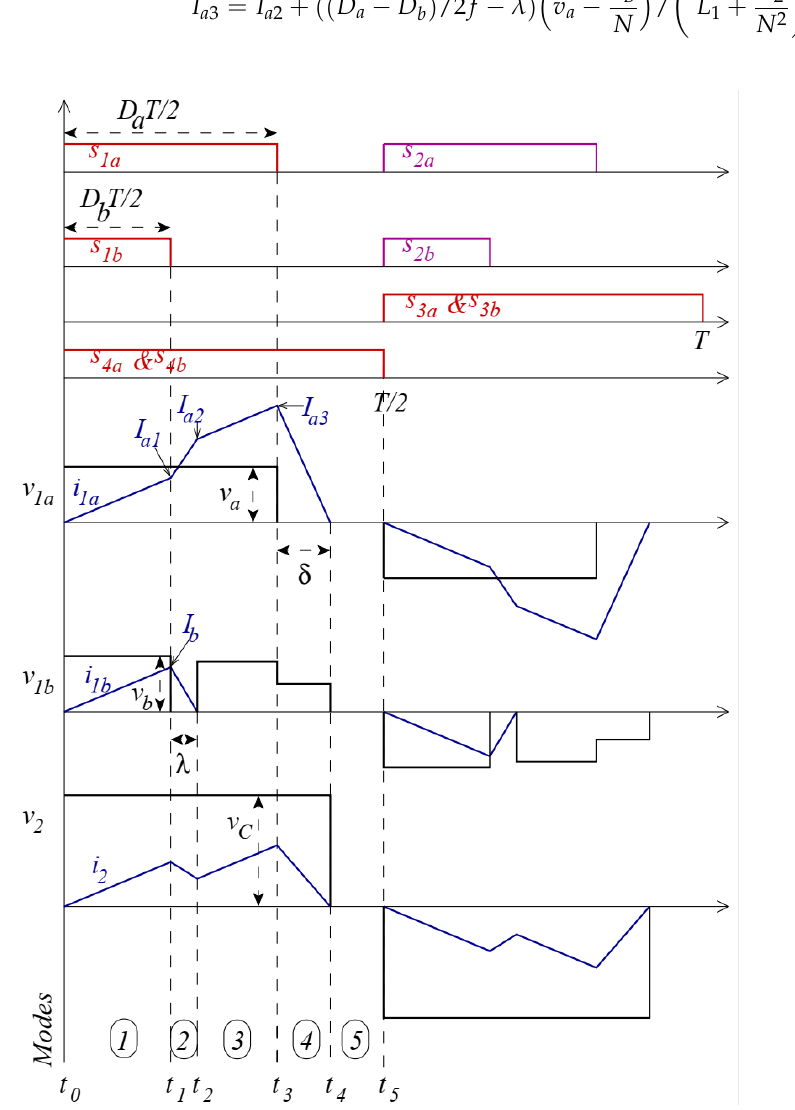
Figure 3. Operating waveforms of the HFMP